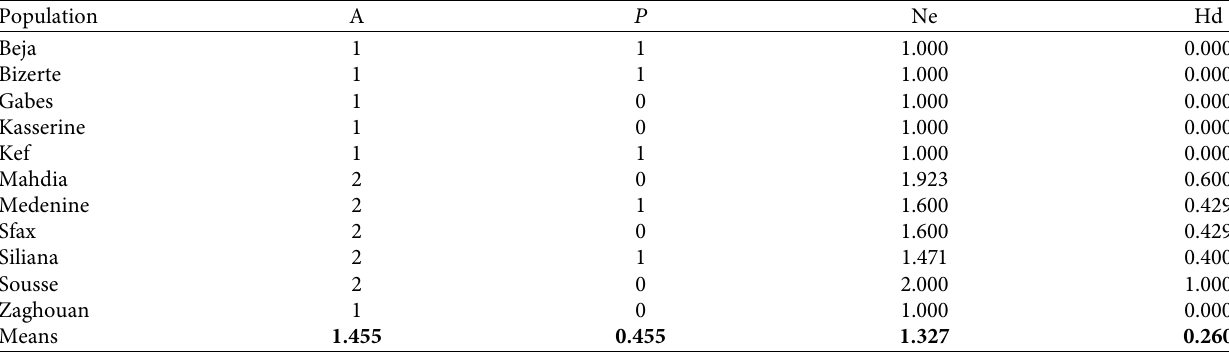
Table 4: Variability of the haplotype genetic indices among the studied populations. A :number of detected haplotypes, P: number of private haplotypes, Ne:effective number of haplotypes, Hd: haplotype genetic diversity. Population